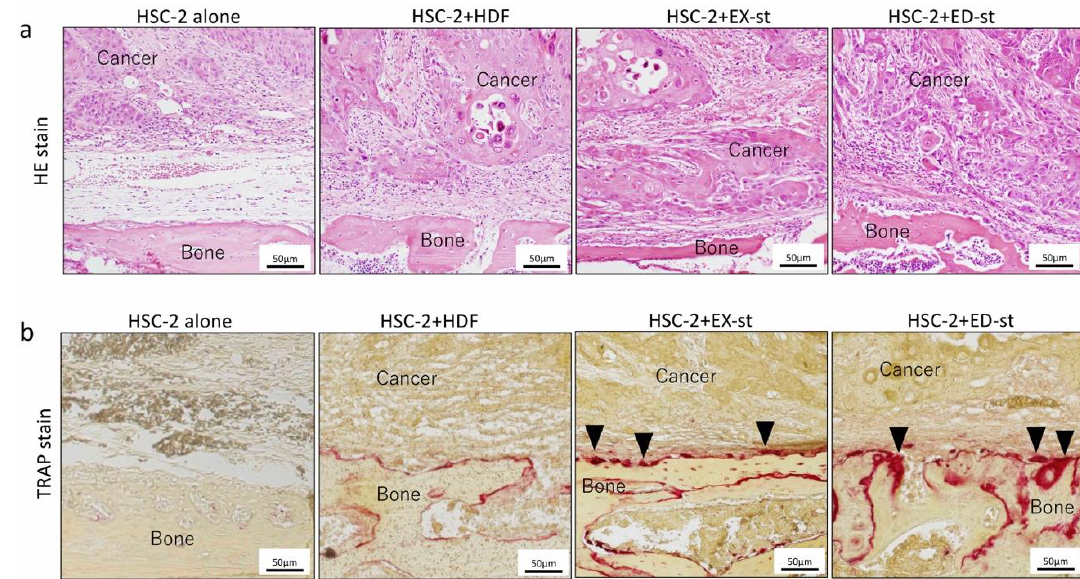
Figure 6. Histological images and tartrate-resistant acid phosphatase (TRAP) staining of tumor tissue at the bone surface in the xenograft model. ( a ) In the HSC-2 / HDF group, the border line between the tumor and the cranial bone was clear, and bone resorption was not observed. In the HSC-2 / EX-st group, slight bone destruction and severe bone destruction were observed. In the HSC-2 / ED-st group, cranial bone resorption was remarkable, and the tumor invasive ability was high. ( b ) The number of multinucleated giant cells in the bone resorption area was higher in the HSC-2 / ED-st group than in the HSC-2 / EX-st group, as indicated by the arrowheads. In the HSC-2 / HDF group, bone resorption was hardly observed.